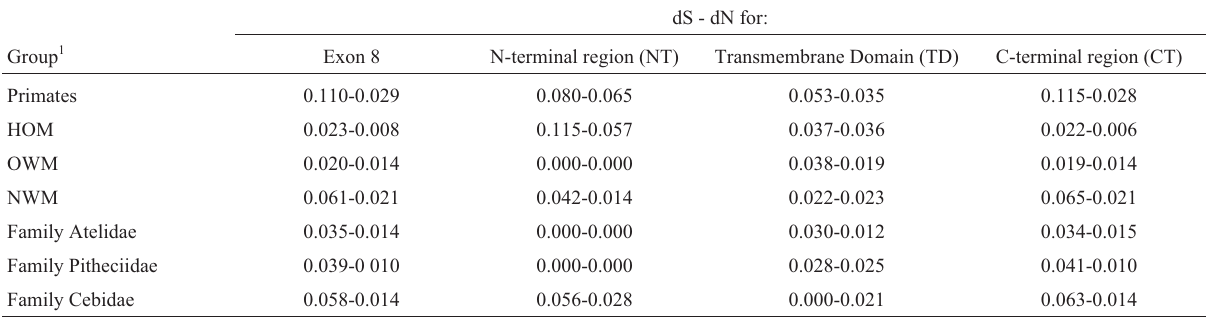
Table 2 - Rates of synonymous (dS) and nonsynonymous (dN) substitutions per site of the H gene for the different primate groups analyzed.